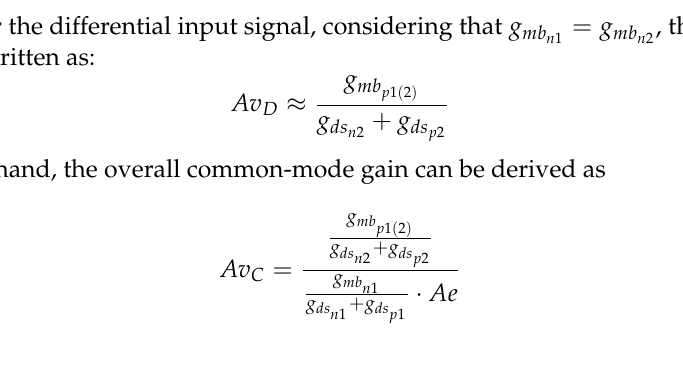
Figure 5. Feedback scheme of the proposed enhanced body-driven